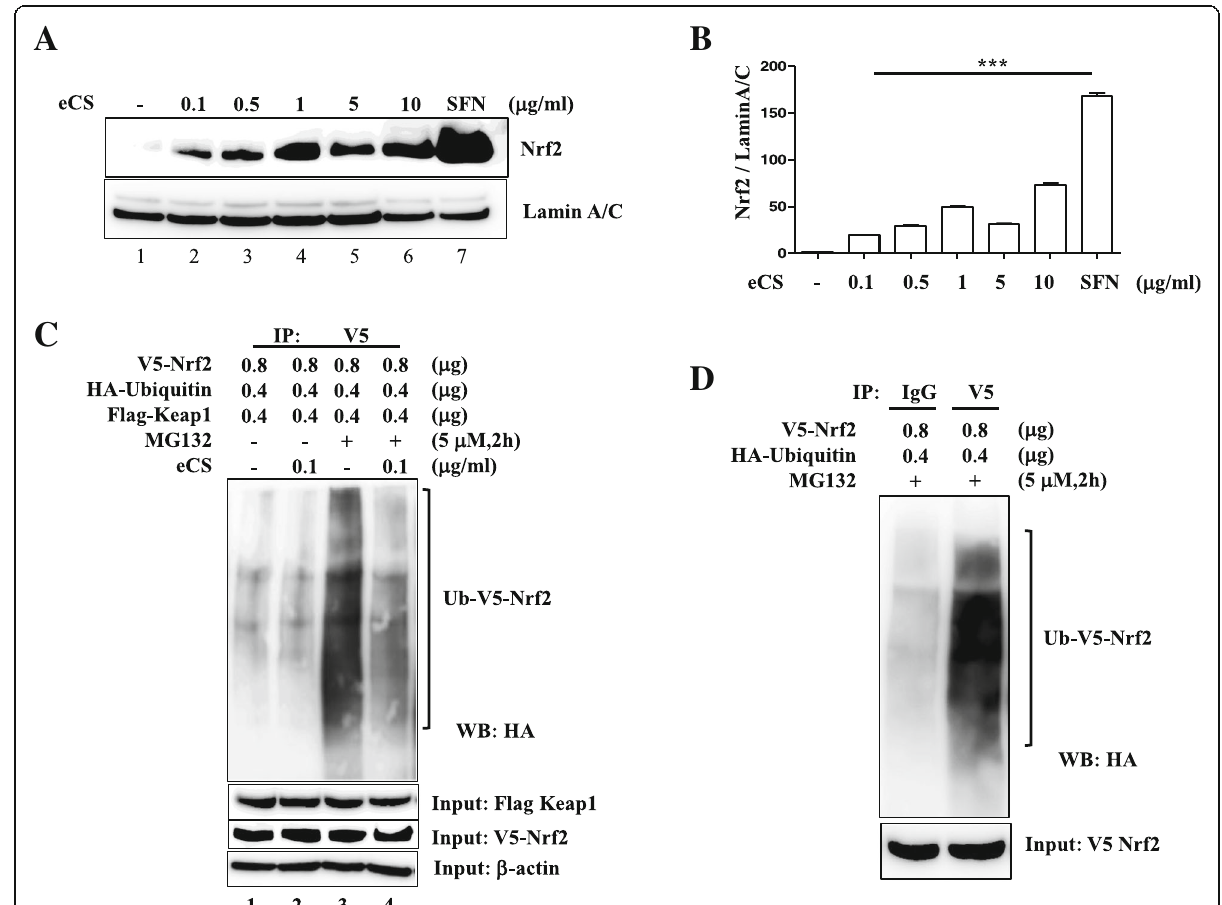
Fig. 4 The effect of eCS on Nrf2 activity. a Nuclear proteins were fractionated from RAW 264.7 cells treated with various amounts of eCS for 16 h and then analyzed by immunoblotting for Nrf2. b The relative amounts of nuclear Nrf2 were calculated over Lamin A/C using ImageJ. *** P was less than 0.0001, compared to the untreated control. Data are presented as the mean±SEM of 3 measurements, and a representative of 3 independent experiments is shown. c HEK 293 cells were transfected with V5-Nrf2, HA-Ub, and Flag-Keap1 and then treated with eCS for 16h with or without MG132 (5 μ M, 2h). V5-Nrf2 in the total cell lysate was precipitated with the anti-V5 antibody and the precipitant was analyzed with the anti-HA antibody to reveal the ubiquitinated Nrf2. One-tenth of total cell lysate was analyzed for Flag (Keap1), V5 (Nrf2), and β -actin, as inputs. d Similarly, HEK 293 cells were transfected with V5-Nrf2 and HA-Ub, along with MG132 (5 μ M, 2h). V5-Nrf2 in the total cell lysate was precipitated with an isotypic IgG or the anti-V5 antibody. The precipitants were analyzed with the anti-HA antibody to reveal the ubiquitinated Nrf2. One-tenth of total cell lysate was analyzed for V5-Nrf2 as in a